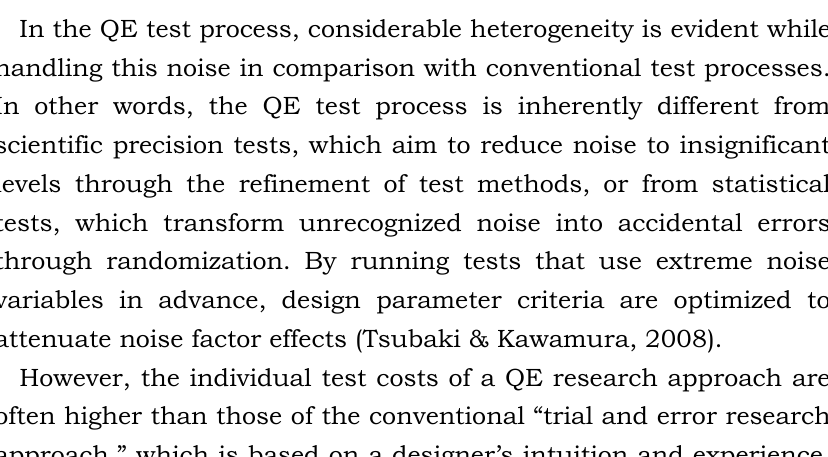
Table 1. Characteristics of “Trial and Error” and “QE” approaches Trial and Error